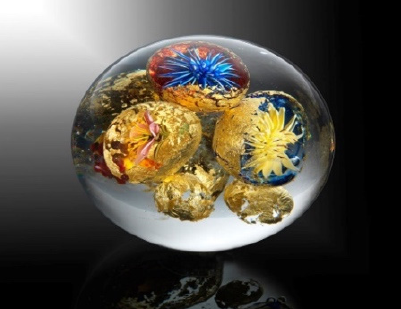
Figure 8. Paul Stankard; Golden Orbs Floating in a Sphere , 2008; gold inclusion within hot flameworked glass; photo credit: Ron Farina, used with permission.